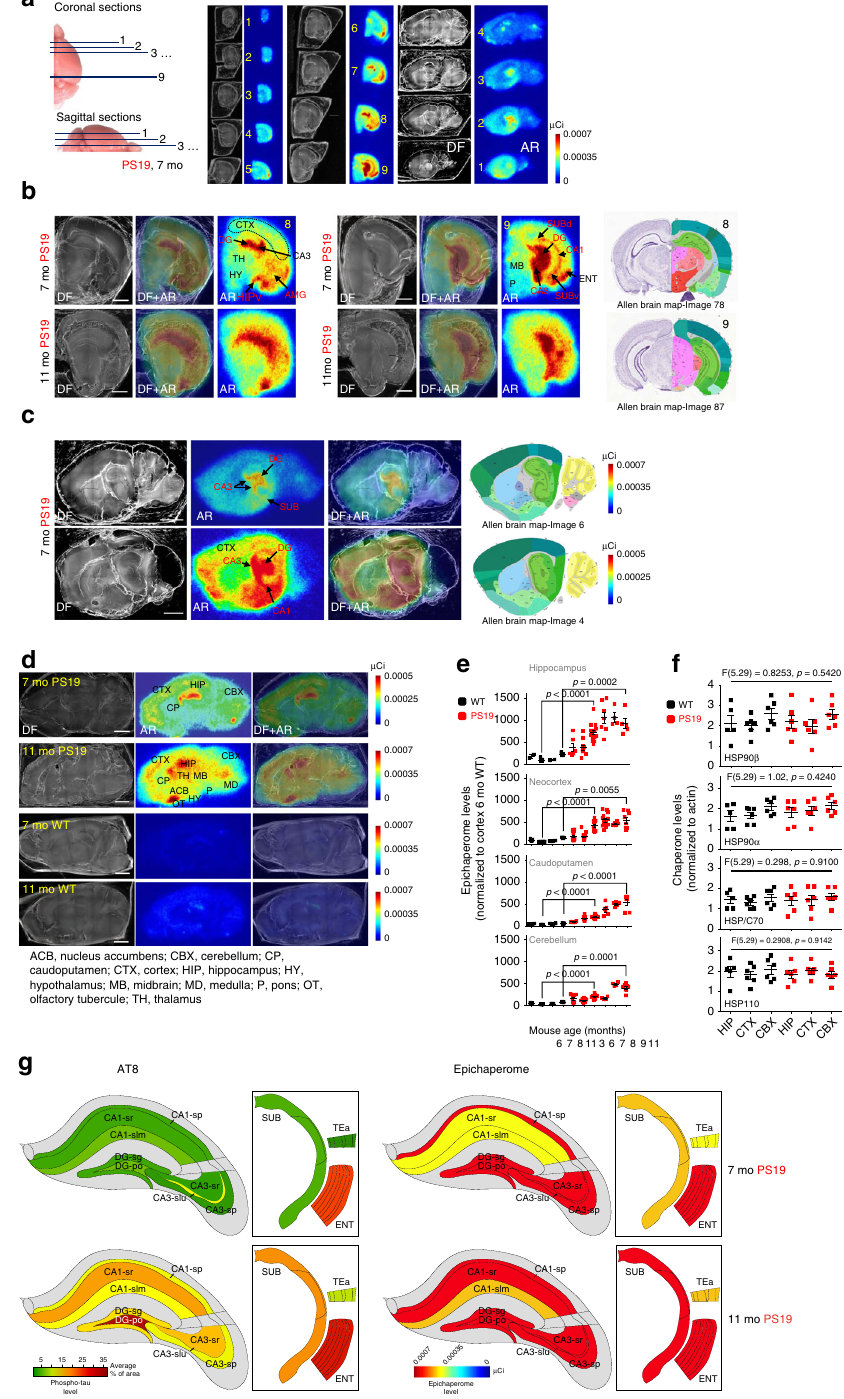
Fig. 1 The epichaperome is expressed in the PS19 mouse brain in a region- and age-dependent manner. a Sectioning and staining to map epichaperome network localization via autoradiography (AR) using 131 I-PU-AD, a radiolabelled chemical probe for epichaperome detection and quanti fi cation, is shown for a representative mouse brain (PS19, 7 months). Dark fi eld (DF) microscopy images were taken to visualize brain anatomy. b – d Indicated coronal ( b ) and sagittal ( c , d ) brain sections like in ( a ) show epichaperome localization and its distribution in PS19 ( n = 5), and its absence in WT ( n = 5), mouse brains. Scale bar, 2 mm. Images for anatomical location of brain areas closest to those used for epichaperome detection were obtained from the Allen Institute for Brain Science, Mouse, P56. e Epichaperome levels analyzed as in ( a ) in the indicated brain regions in WT and age-matched PS19 mice show its age- dependent and PS19-speci fi c expression. Graph, mean ± SEM; unpaired two-tailed t -test, PS19 ( n = 14 and 5) vs WT ( n = 7 and 5) at 7 and 11 months, respectively. f Levels of individual chaperones in 8 – 10 months old WT ( n = 6) and PS19 ( n = 6) mice, determined by western blot. Graph, mean ± SEM; one-way ANOVA. See also Supplementary Fig. 2A. g Schematic summary showing the spatio-temporal expression of the epichaperome compared to hyperphosphorylated human tau (measured by AT8, IHC, see Supplementary Fig. 2B) in PS19 mice. Source data are provided as a Source Data fi